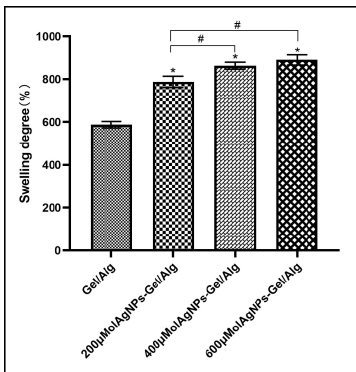
Figure 4. Swelling rate of AgNP–Gel / Alg sca ff old with di ff erent concentrations of AgNPs. * p < 0.05 vs. control group; # p < 0.05 vs. 200 µ M AgNP–Gel / Alg